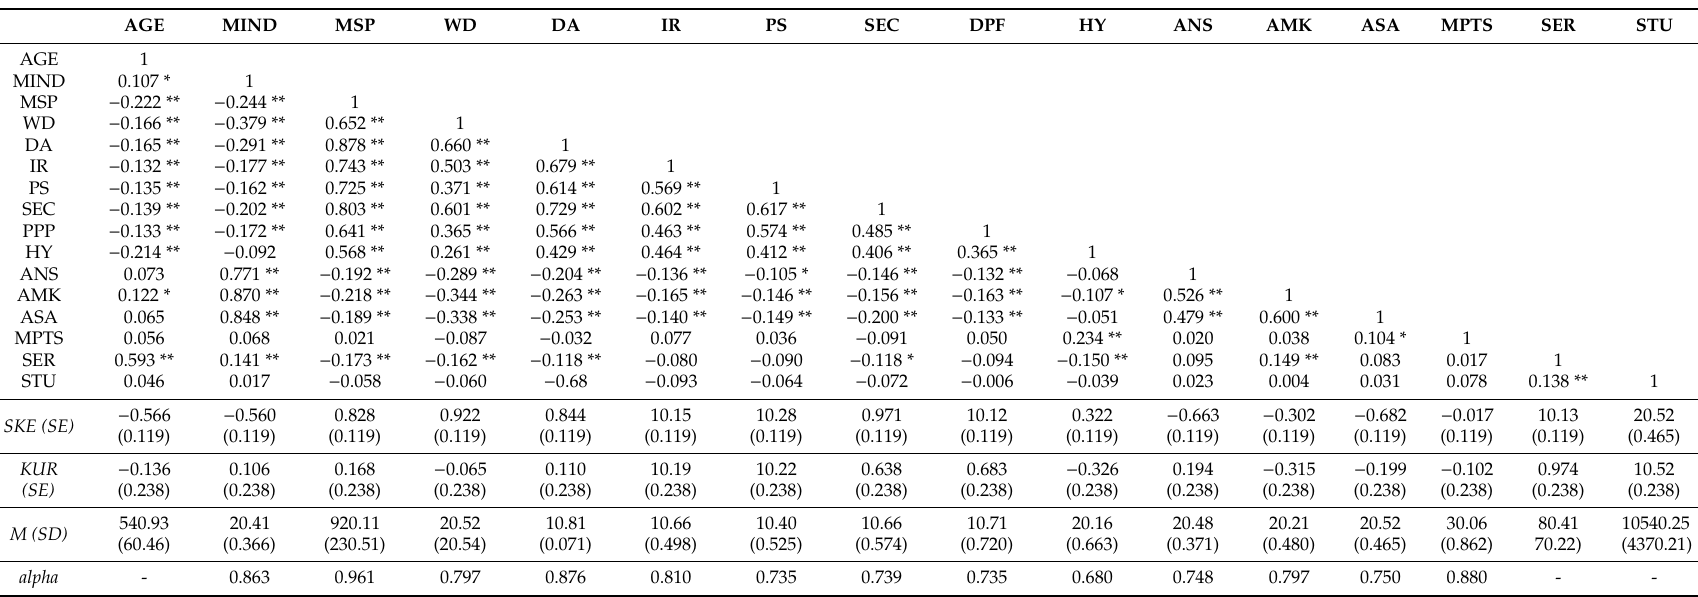
Table 2. Bivariate